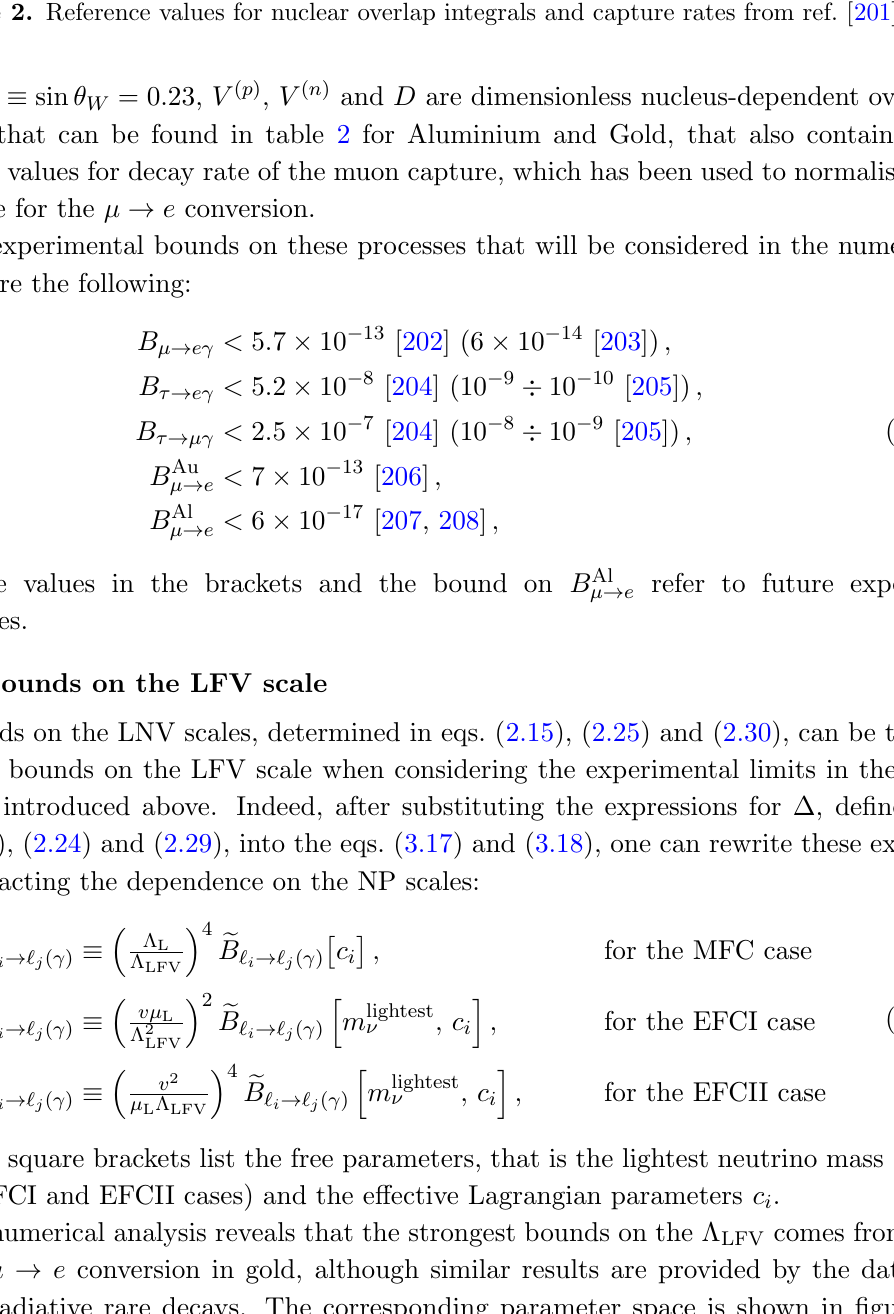
Table 2. Reference values for nuclear overlap integrals and capture rates from ref.